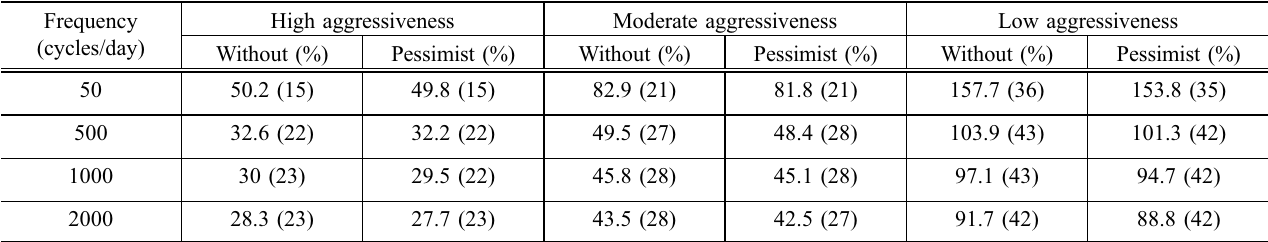
Table 8 Mean (in years) and coefficient of variation (between brackets) of the total lifetime for the tropical environment. Frequency